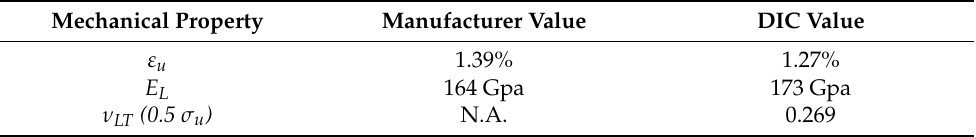
Table 11. Mechanical properties of the CFRP cable: manufacturer (average) vs. DIC values. (1) Longi- Poisson’s coefficient ( ν LT